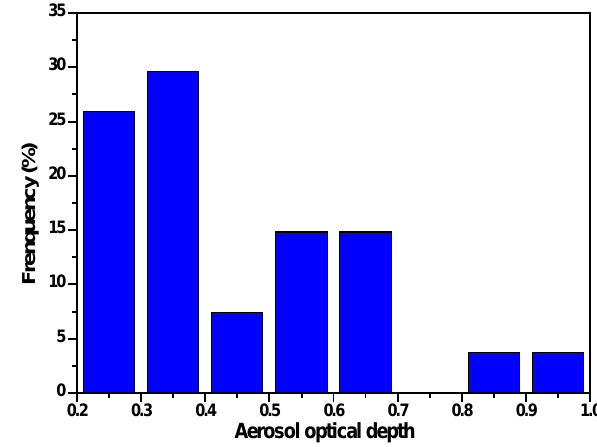
Fig. 3. AOD frequency distributions at 500 nm in MAM 2009 at SACOL.